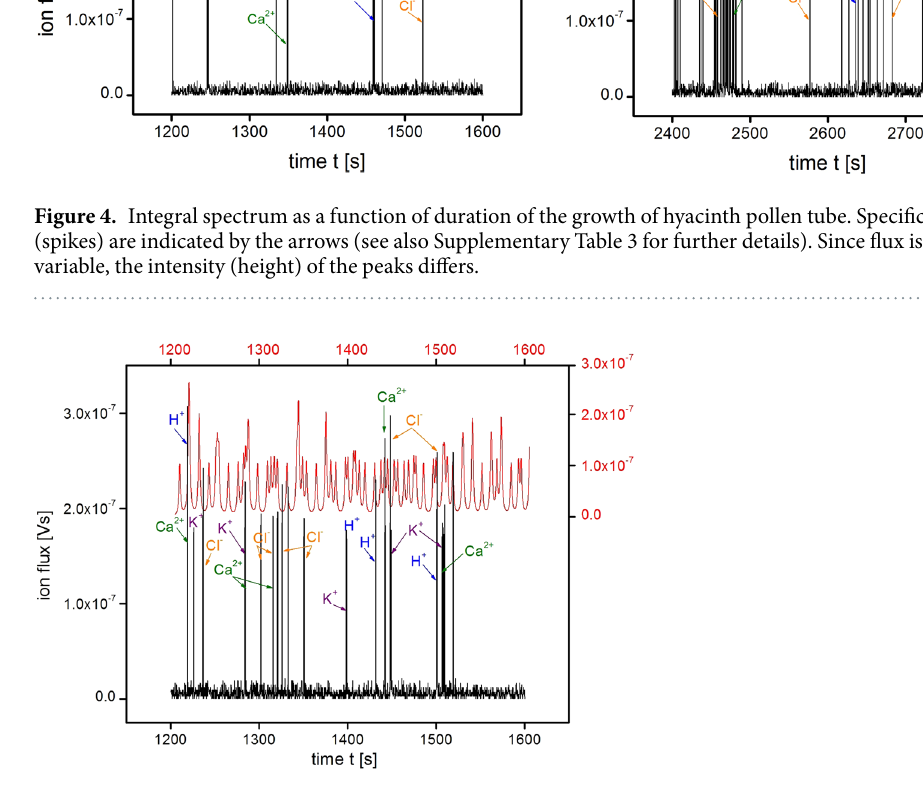
Figure 5. Combined spectrum of the ion fluxes that were present in the oscillations of the hyacinth pollen tube with the calculated flux pattern